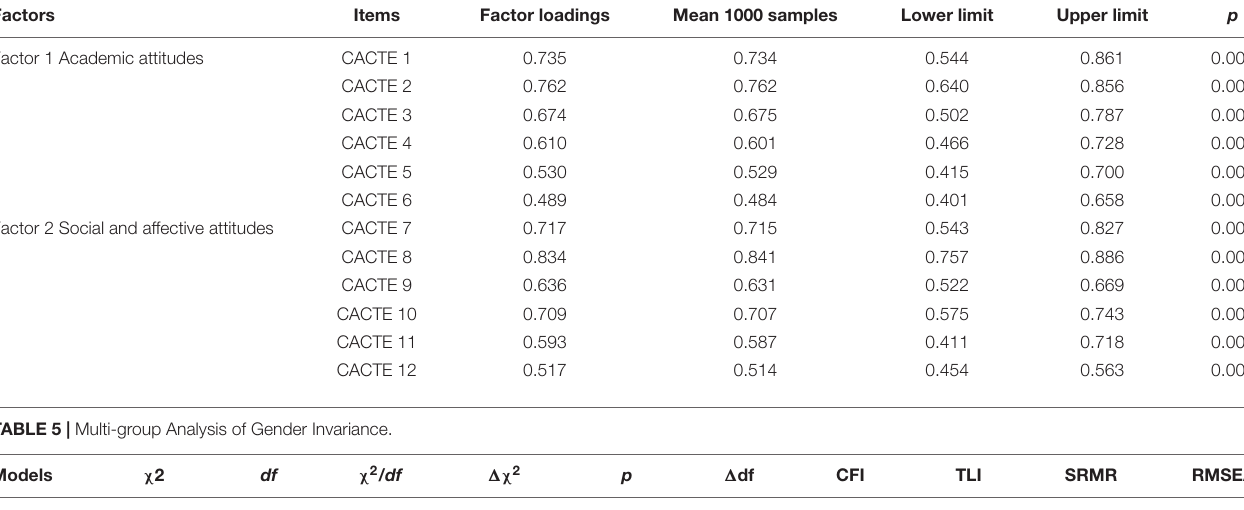
TABLE 4 | Bootstrap method, 1000 samples with a 95% Confidence Interval.